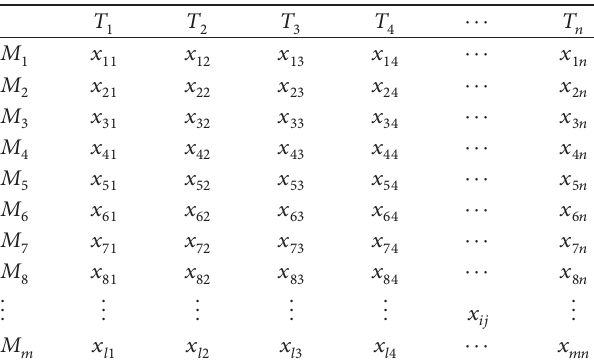
Table 2: The decision table of